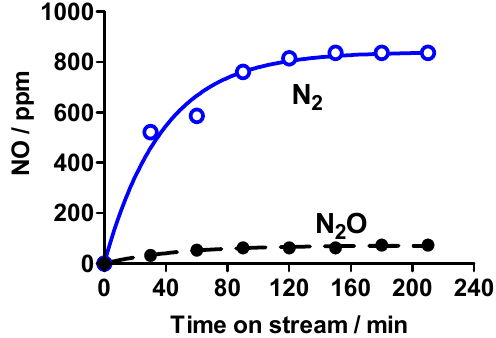
Figure 20. Outlet concentration of N 2 and N 2 O in the SCR of NO with ammonia at 323 K under irradiation. Conditions: TiO 2 loading, 1.2 g; volume of catalyst bed, 1.5 mL; irradiation, 300-W ultra-high pressure Xe lamp reflection by a cold mirror; composition of reaction gas, 1000 ppm NO + 5% O 2 , and balance was Ar gas; flow rate, 100 mL min − 1 ; k N = 0.026 ± 0.003 min − 1 , k N = 0.021 ± 2 2 O 0.003 min − 1 . Adapted with permission from Tanaka et al. [105]. Copyright 2002 by the Royal Society of Chemistry (License No.: 4452660060880).